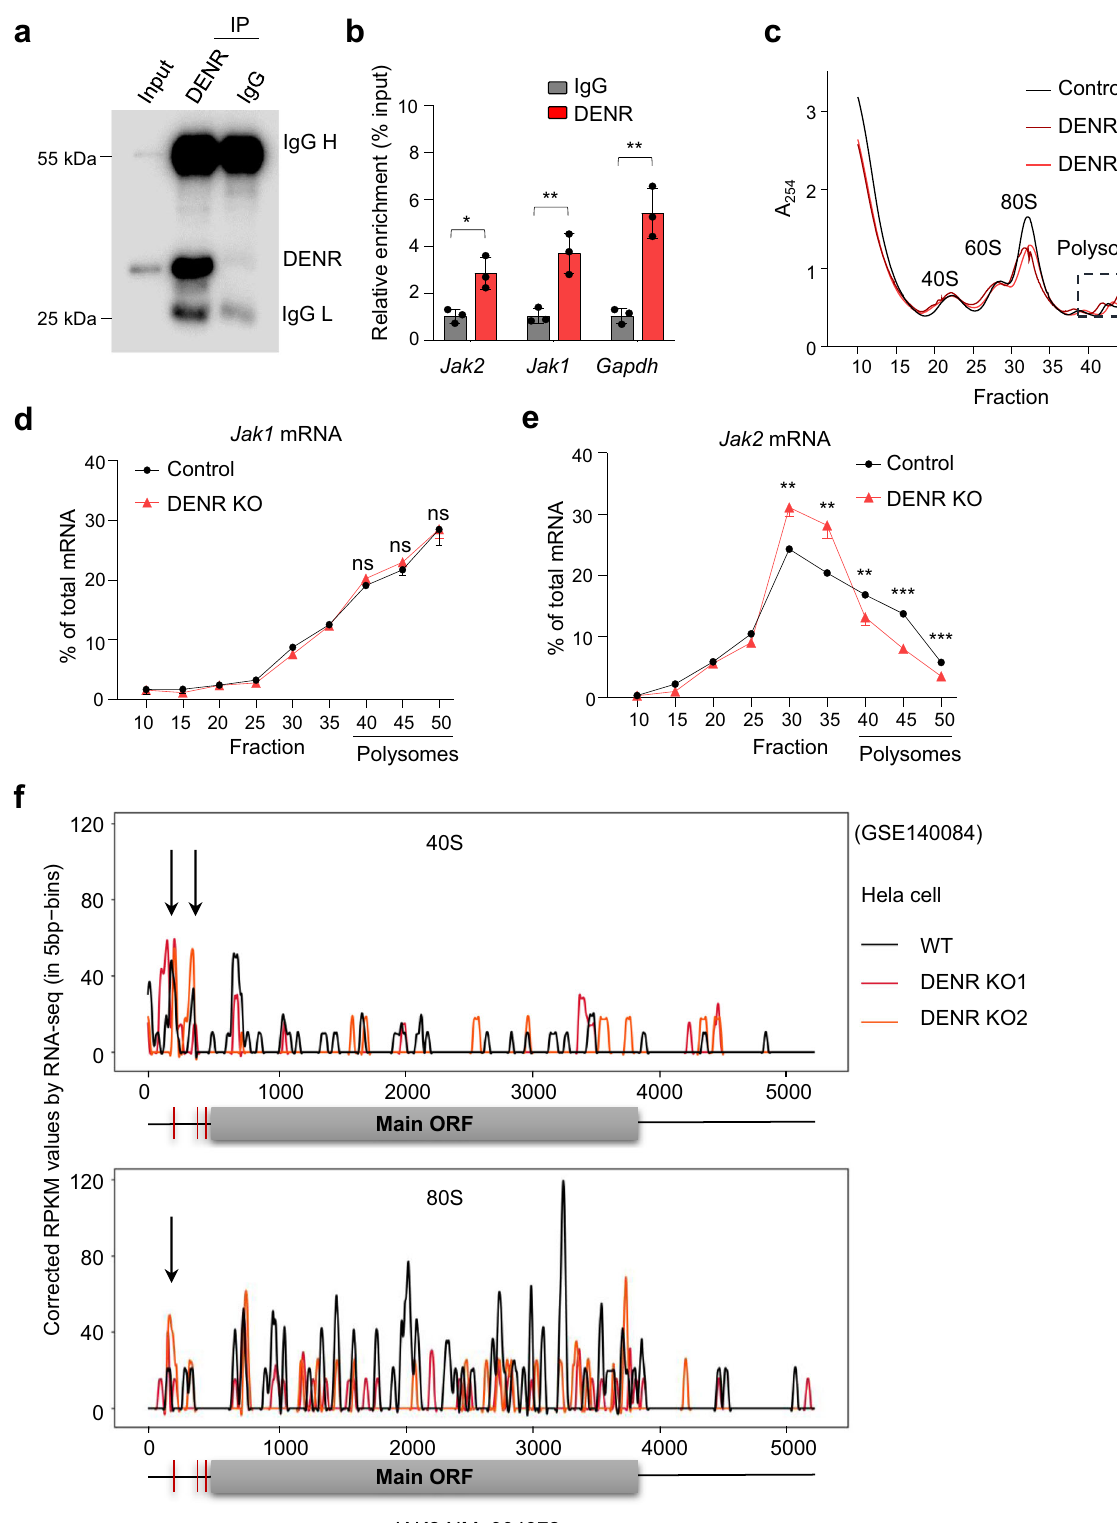
function in tumor microenvironment of the tumor patients